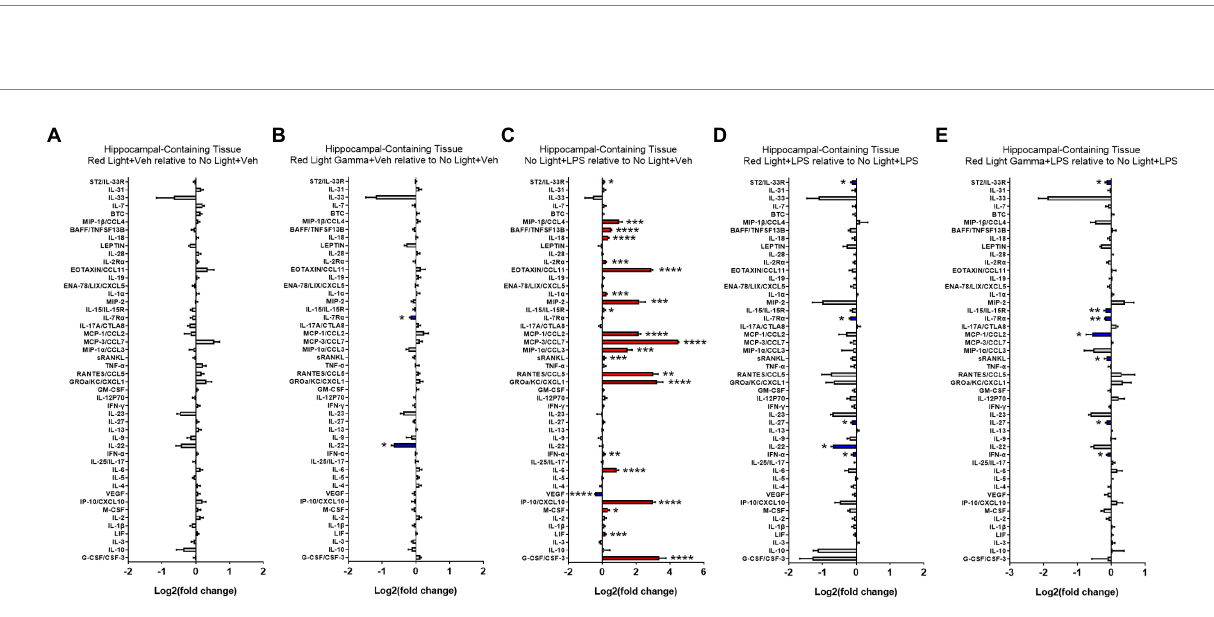
Red light or red light with 40 Hz flicker did not alter AKT, ERK, or GSK3 β In addition to the cytokine analyses by Luminex assay, protein levels of AKT, phospho-AKT, GSK-3 β , phospho-GSK3 β , ERK 1/2, phospho-ERK 1/2, ATG5, phospho p70S6k, and p70S6k were evaluated by western blot (WB). No significant differences between the treatment groups were detected for the proteins measured by WB (Supplementary Figures S4–S7).